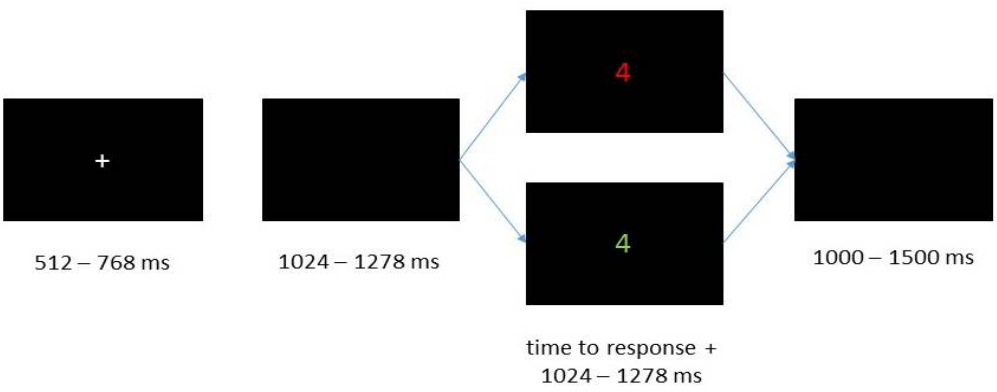
Figure 2. Representation of the sequence of one trial.